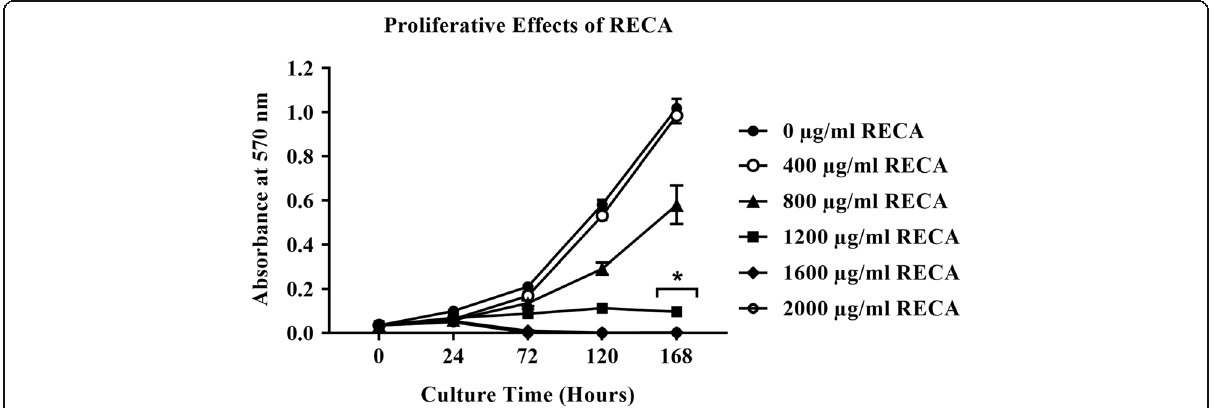
Fig. 6 The effects of RECA on the proliferation of Schwann cells. The cell viability for each concentration of RECA was analyzed using the MTT assay at different time points (24 h, 72 h, 120 h and 168 h of RECA treatment). The absorbance was read at 570 nm and the value represents the mean ± SEM ( n = 3). * indicates significant differences between the viability of Schwann cells treated with RECA at ≥ 1200 μ g/ml compared to the